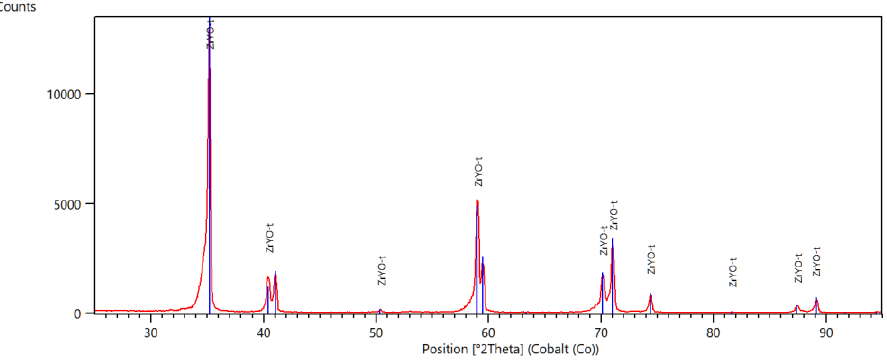
Figure 1. Diffractogram of a milled sample, F.